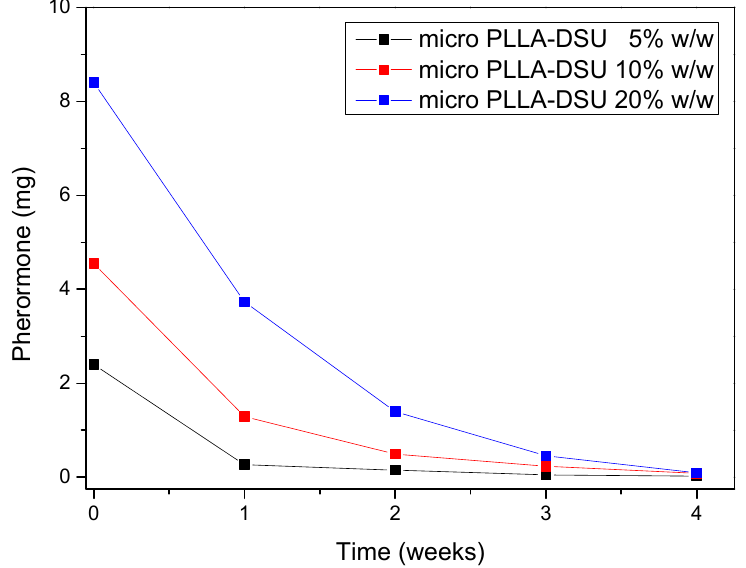
Figure 7. Amount (mg) of the remaining pheromone in PLLA microspheres after LE.